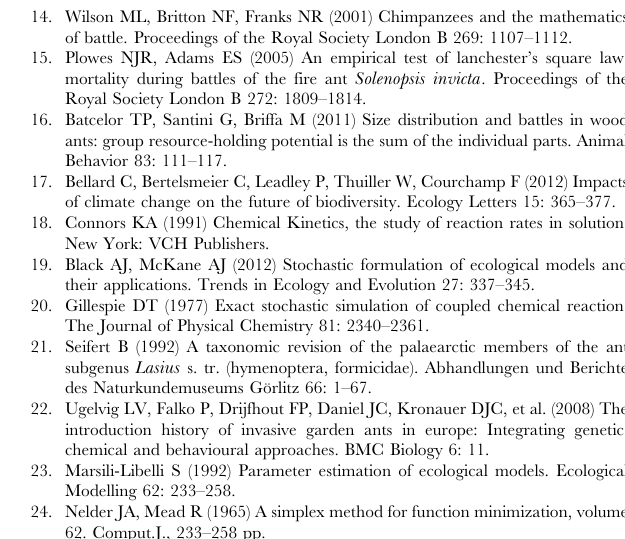
Figure S3 Chemical species AB . The abundance of the chemical species AB is shown as a function of time up to the steady state for three values of the initial conditions. (TIFF) Figure S4 Chemical species ABB . The abundance of the chemical species ABB is shown as a function of time up to the steady state for three values of the initial conditions. (TIFF) Figure S5 Chemical species ABBB . The chemical species ABBB is shown as a function of time up to the steady state for three values of the initial conditions. (TIFF) Figure S6 Scheme. Schematic representation of the proposed methodology followed to compare the deterministic model, expressed by means of a system of nonlinear differential equations, and the stochastic one. (TIF) Figure S7 Experimental data and deterministic model for species AB . The mean values of the chemical species AB obtained from 20 experiments vs. the solution of the deterministic model by means of Simplex Flexible Algorithm(SFA). (TIFF)